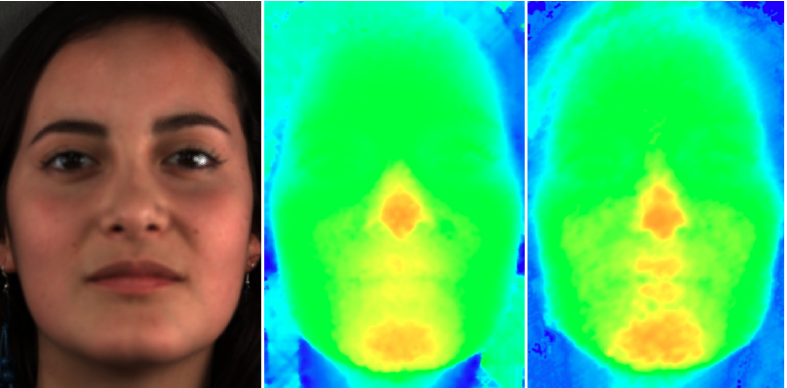
Figure 12. Resulting depth map using a Raytrix light-field camera. ( Left ): original face image; ( center ): Raytrix software output depth map; ( right )—output depth map using [38].